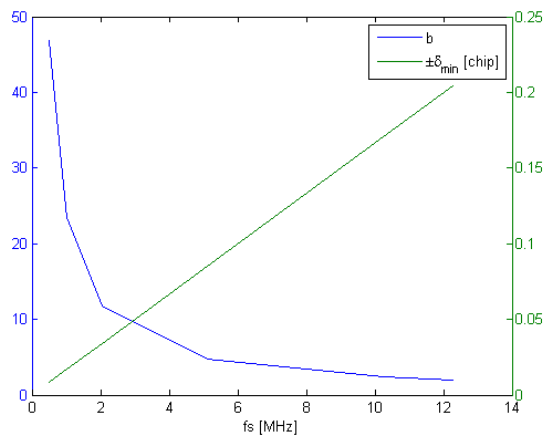
Figure 8. b and (cid:2012) (cid:3040)(cid:3036)(cid:3041) vs. 1/(cid:1846) (cid:3046) with a 22.3 MHz Front-end Bandwidth at 60 MHz. Figure 8. b and δ min vs. 1 { T s with a 22.3 MHz Front-end Bandwidth at 60 MHz.